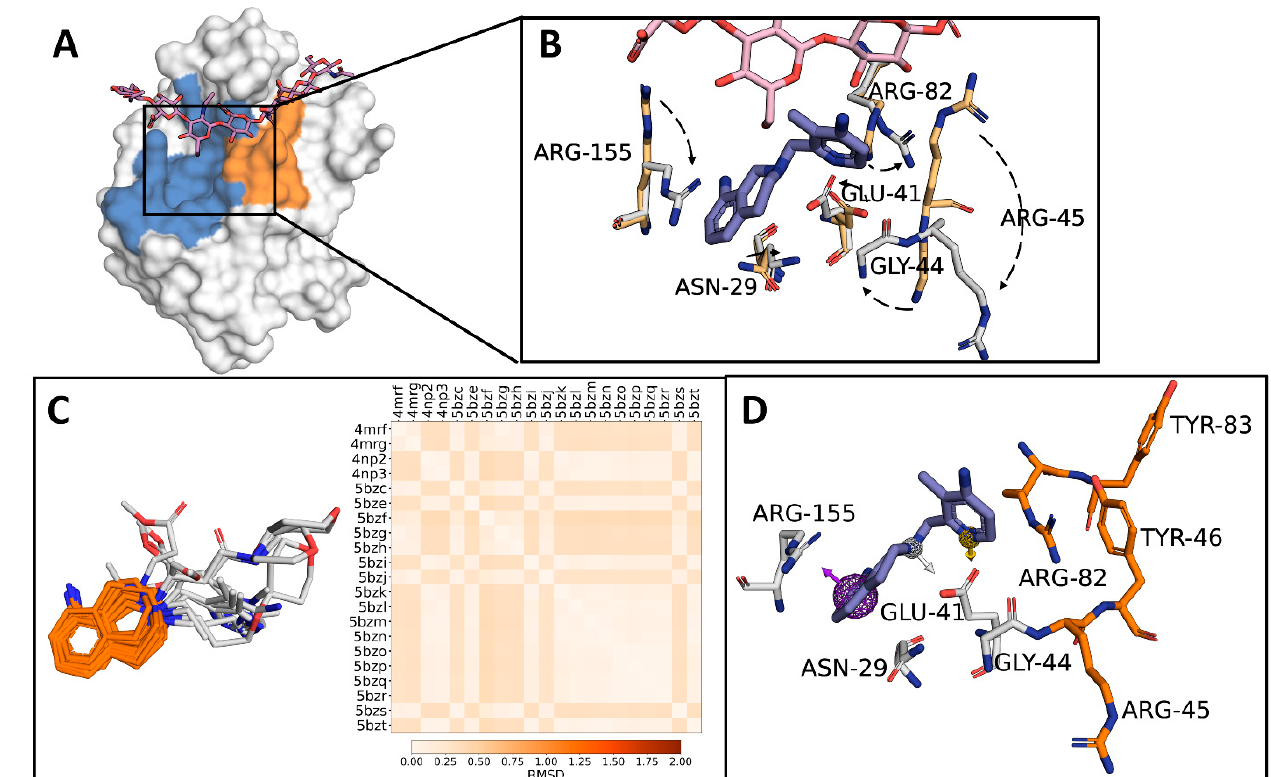
Figure 1. Generation of a 1,2,3,4-tetrahydroisoquinoline (THQ)-based pharmacophore. ( A ) CD44HAbd (white surface) has a subdomain where the THQ-containing molecules can bind (blue) and partially overlaps with the region containing the key residues for CD44–HA binding (Arg45, Tyr46, Arg82, and Tyr83-orange-). HA is shown in pink. ( B ) Spatial positions of the lateral chain of residues Asn29, Glu41, Gly44, Arg45, Arg82, and Arg155 from mCD44HAbd in the HA-bound form (residues shown as beige sticks; HA in pink) vs. the form bound to a THQ-containing molecule (residues shown as grey sticks; ligand in blue). Dashes represent the residue shifts between both states. ( C ) Structural alignment and root mean square deviation (RMSD) comparison of the THQ scaffold (orange) of the molecules co-crystallized with mCD44HAbd. ( D ) Pharmacophore model generated using THQ-containing molecules as a template. Purple sphere: aromatic; yellow sphere: hydrogen bond donor; white sphere: merged hydrogen bond donor and positively charged ion. A molecule with the THQ substructure is included (blue) to show the interacting residues in CD44 (grey sticks) and its proximity to residues essential for HA-binding (orange sticks).